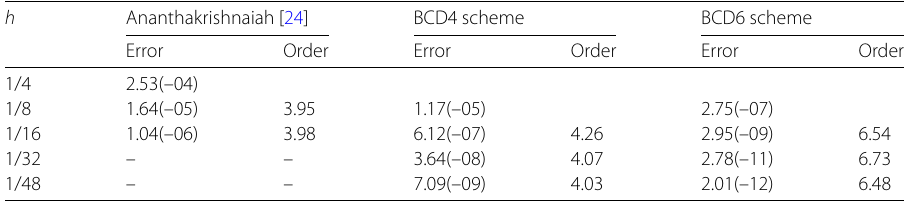
Table 4 The maximum error and convergence order for Problem